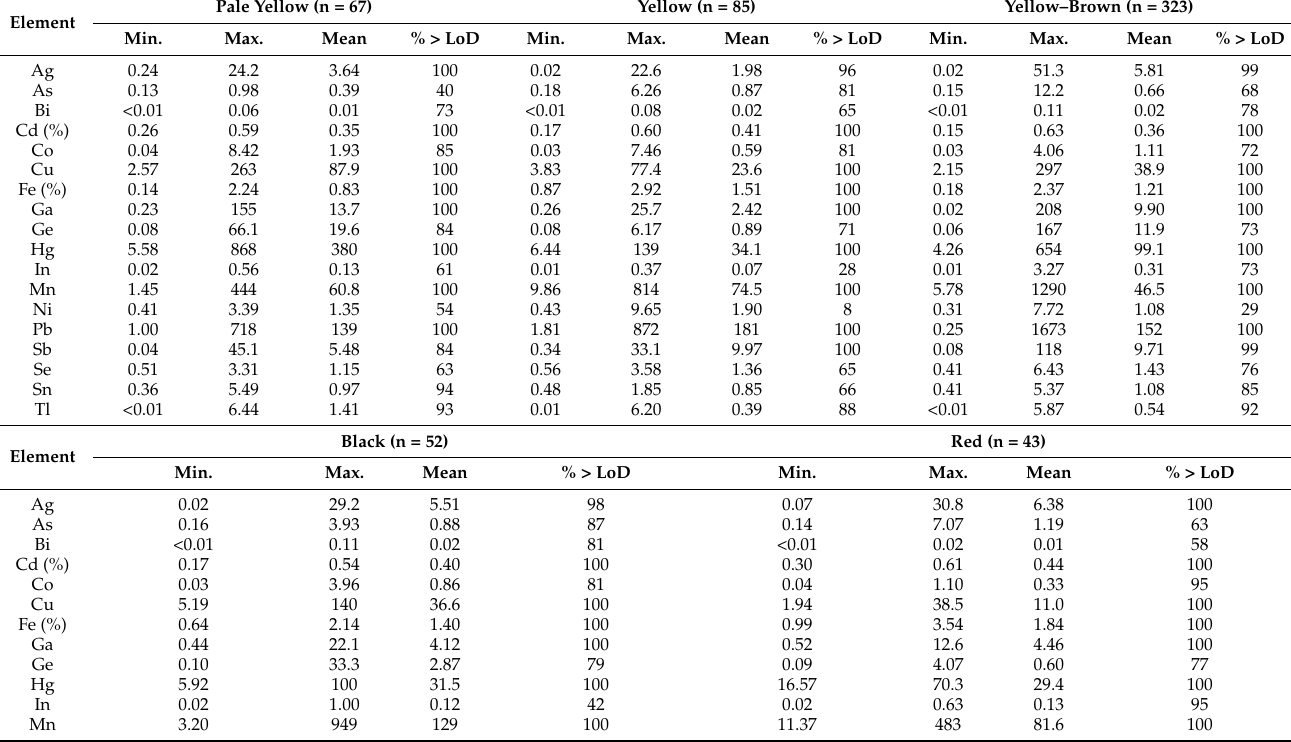
Table 3. Trace element contents of sphalerite by color. All units are in ppm unless otherwise